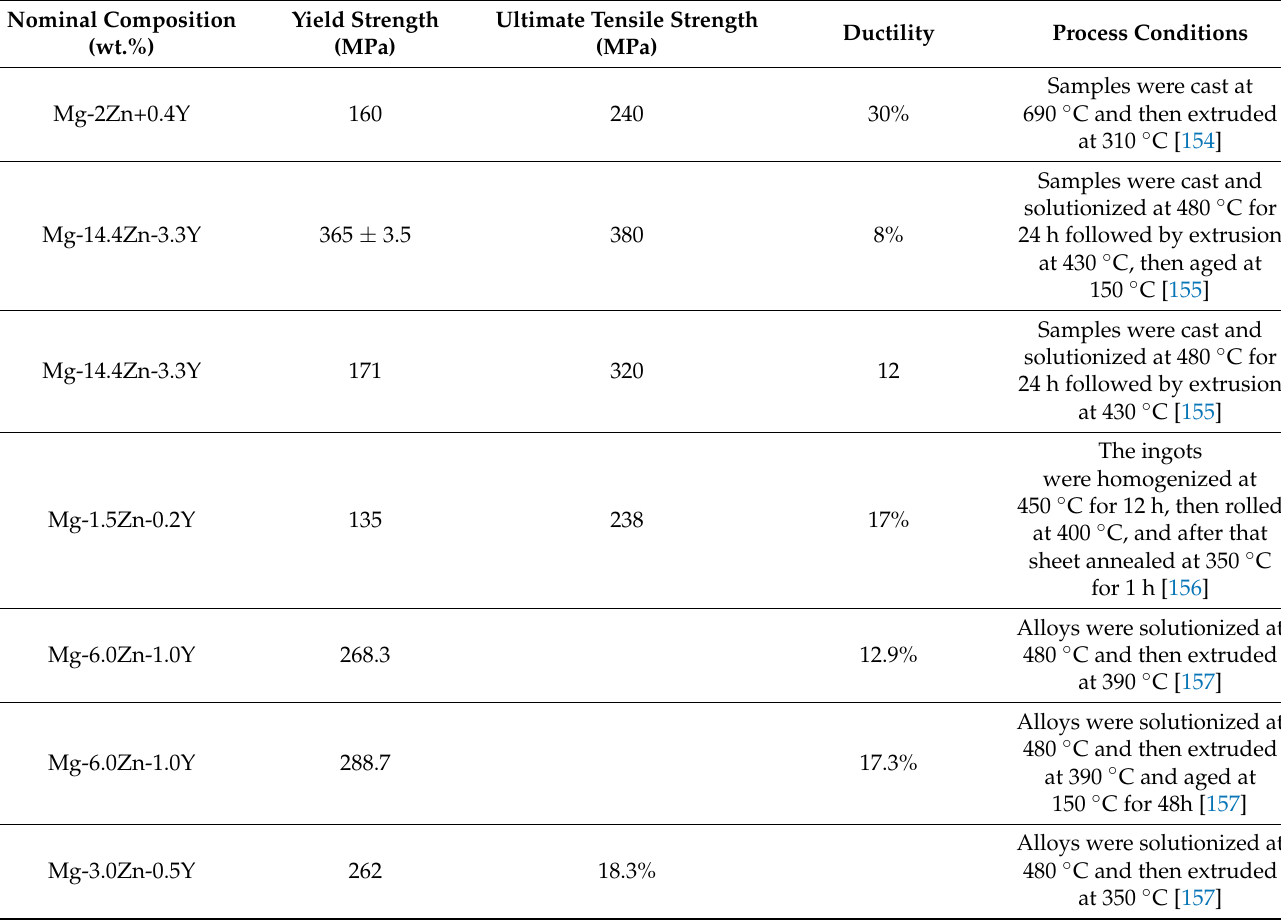
Table 3. Mechanical properties of Mg-Zn-Y alloys.